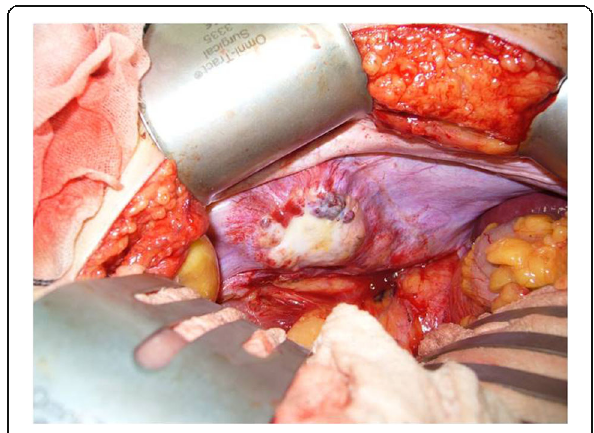
Fig. 5 Intraoperative abdominal view of an elastic, hard, milky-white tumor with a rough surface. Capillary development is evident in the right lower